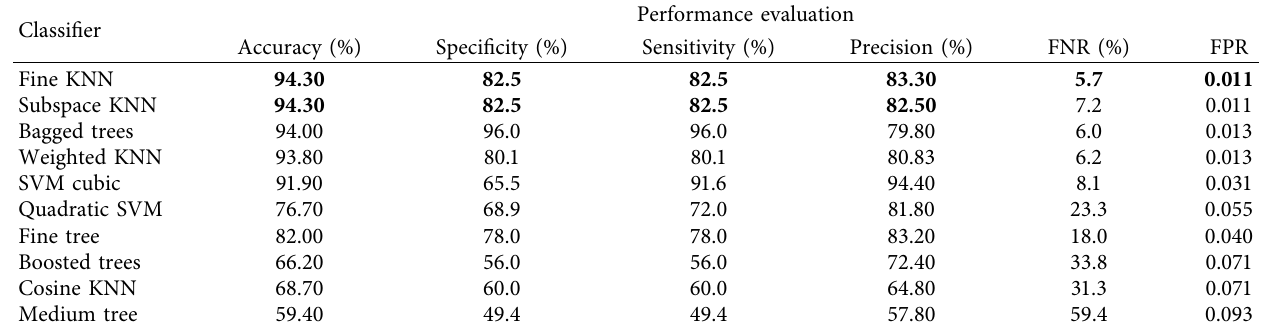
Table 3: Result for experiment